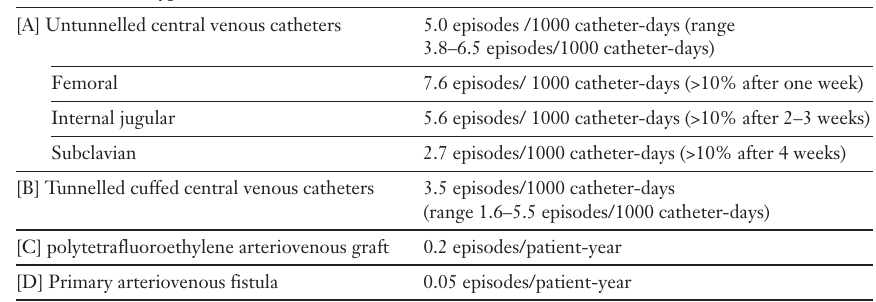
Type of vascular access and infection rates [5–8].